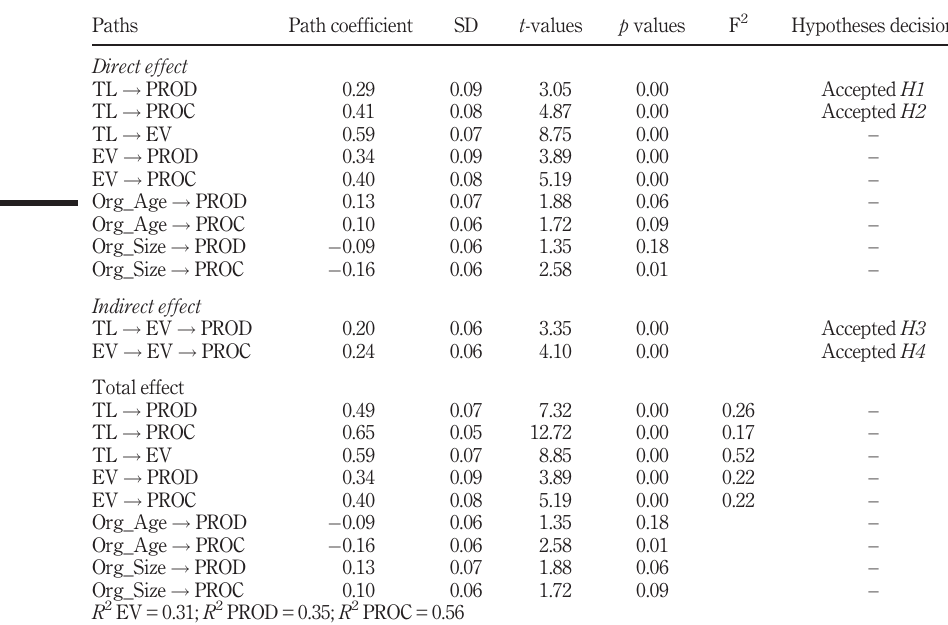
Table 5. Path analysis and hypotheses